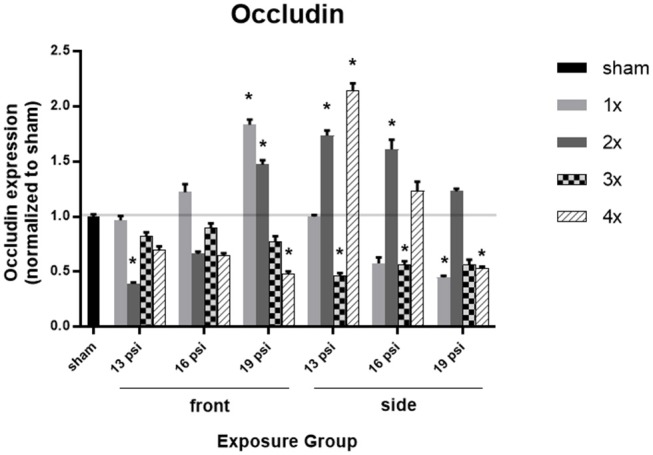
Quantification of occludin expression measured by Western blot. Results presented as blast intensity for each orientation (front vs. side). Values normalized to sham. Statistical significance compared to sham: *p < 0.05 (Significance values in Supplemental Table 2). Data is expressed as mean ± SEM, normalized to sham. Representative Westerns shown in Supplemental Figure 1.